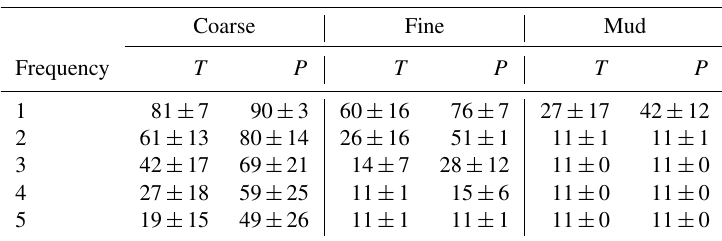
Table 4. Percentage of bioturbation (average ± SD) remaining after sustained trawling activity at a given trawling frequency (yr − 1 ), for the different sediment types. T : deeply penetrating tickler gear, P : shallow-penetrating pulse gear.